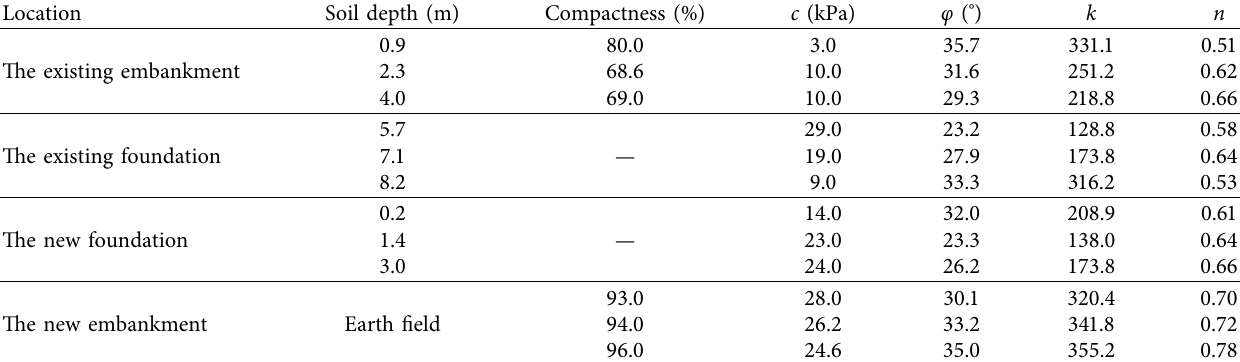
Table 1: Soil mechanical parameters corresponding to the existing embankments height H � 4m.